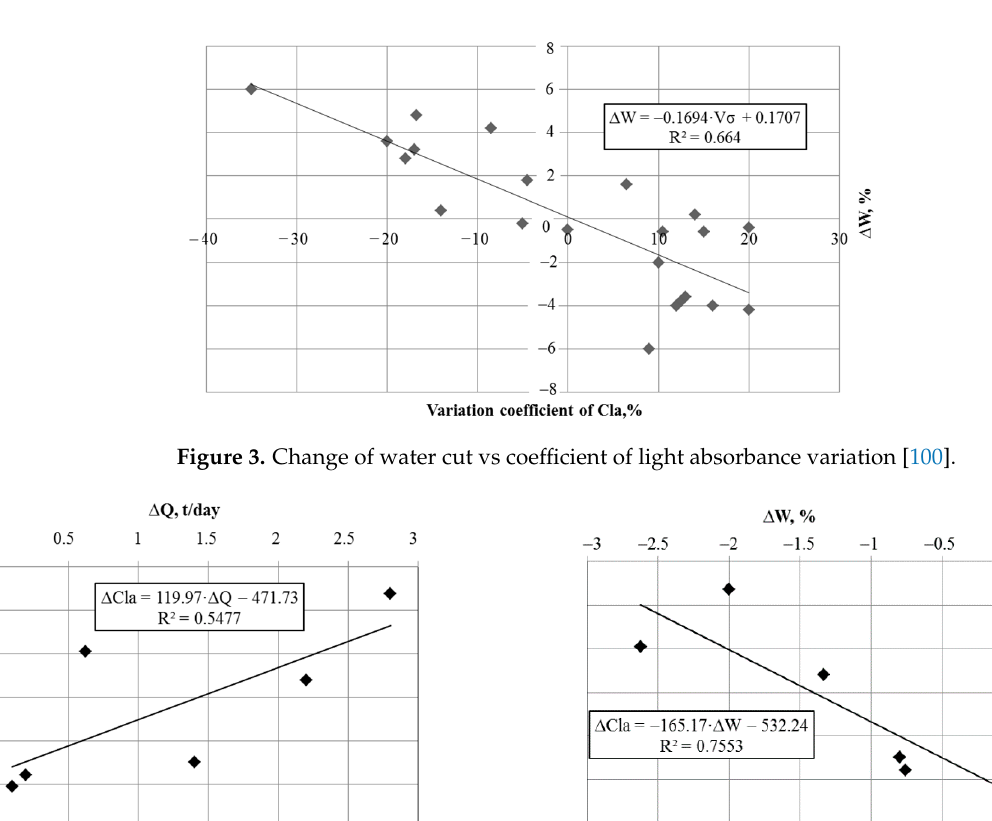
Figure 4. Coefficient of light absorbance variation vs oil production rate ( a ) and change of water cut of produced product ( b ) [101].